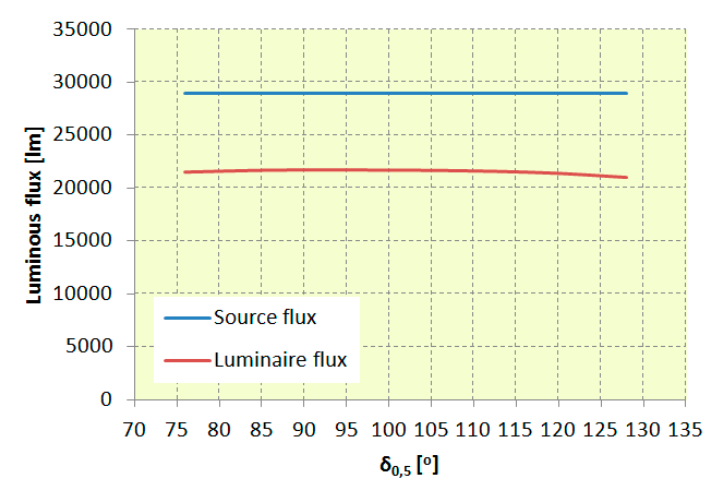
Figure 30. Luminous flux as a function of beam angle.